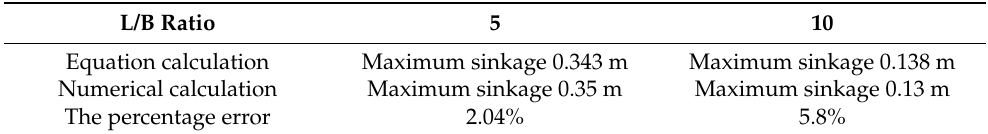
Table 9. Comparison of numerical calculation and prediction formula for maximum displacement of L/B = 5 and 10.